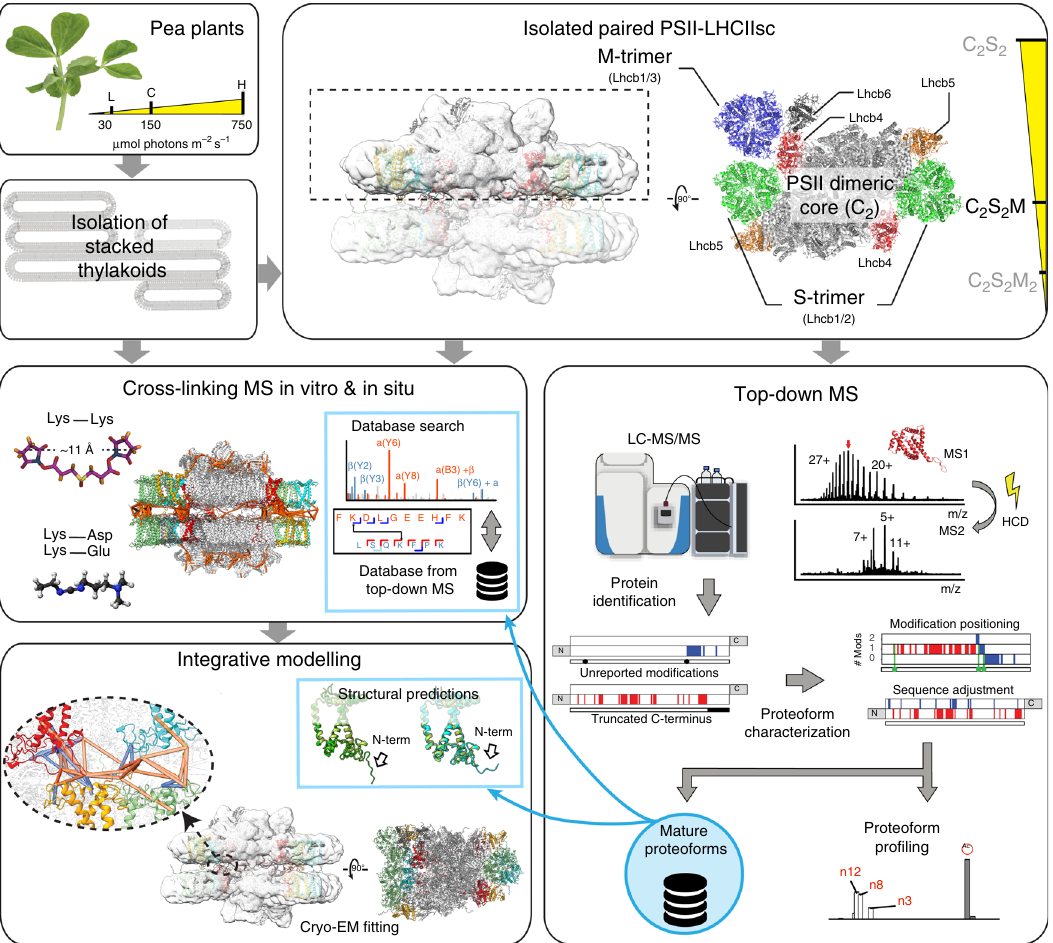
Fig. 1 Work fl ow of the integrated MS-based approach for characterizing the light-driven modulation of paired PSII – LHCIIsc. Isolation of heterogeneous mixtures of PSII – LHCIIsc from pea plants grown at different light intensities (L, low; C, moderate used as control; H, high). PSII – LHCIIsc preparations were used for TD-MS and XL-MS in vitro, performed with DSSO and EDC crosslinkers on two independently isolated PSII – LHCIIsc for each light condition pooled together. DSSO XL-MS in situ was conducted on thylakoid membranes isolated from three independent batches of pea plants grown in moderate (C)